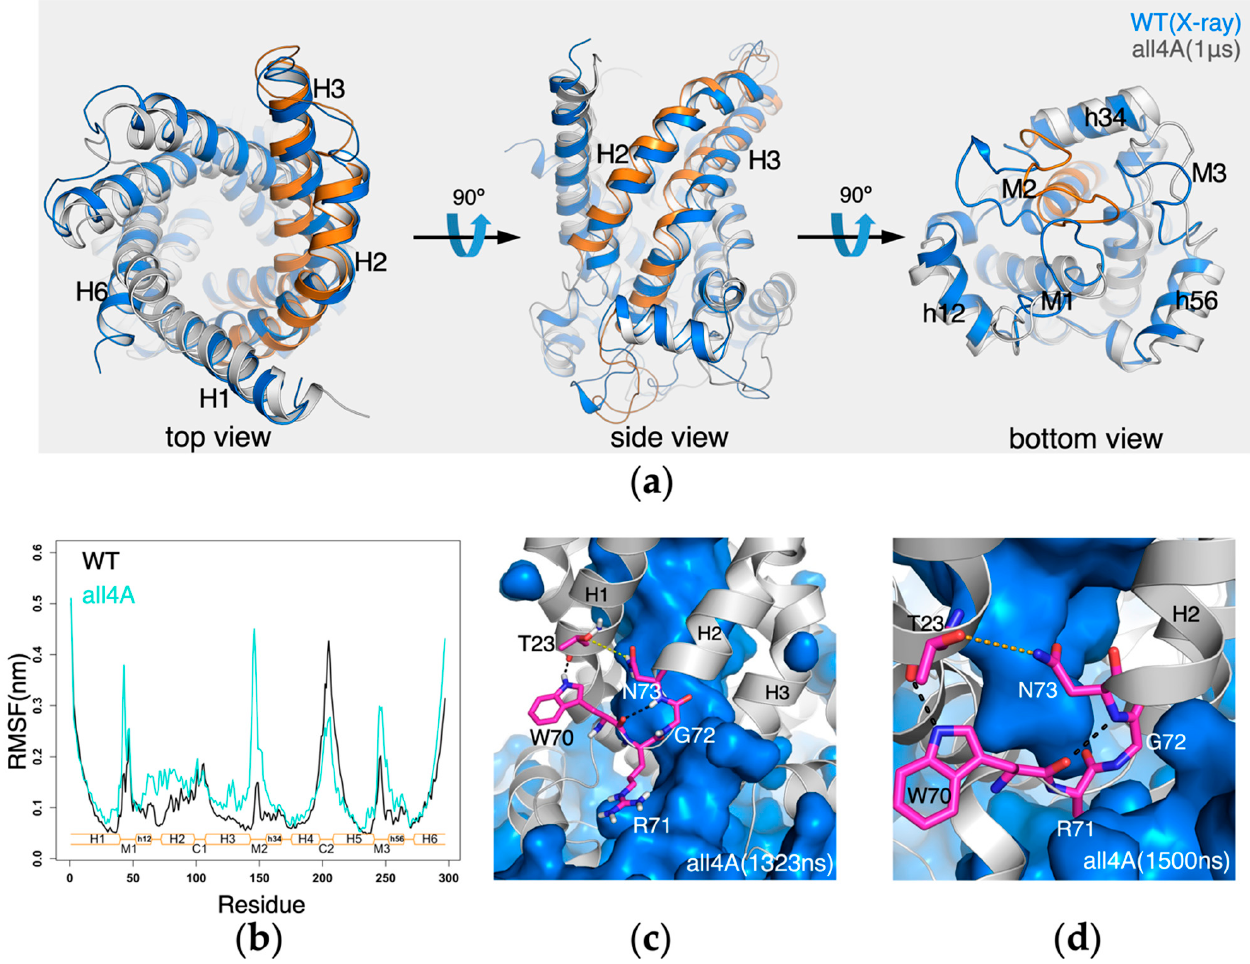
Figure 7. Changes in the structure and dynamics in all4A-AAC . ( a ) Superposition of the structures at the end of the simulation (1 μ s) to the crystal structure (PDB: 1OKC). The H2, C1 loop, H3 and M2 loop of the simulated structure are present in cartoon mode and highlighted in orange. ( b ) RMSF of all4A-AAC compared to that of wild-type AAC . The RMSF were calculated on each trajectory from 200 ns to 1 μ s. ( c ) A crevice formed between the matrix end of H3 and the β -turn structure of the [YWF][KR]G motif which allows for the passing through of the solvent. ( d ) The crevice between H2 and H3 interface became closed after transient opening.